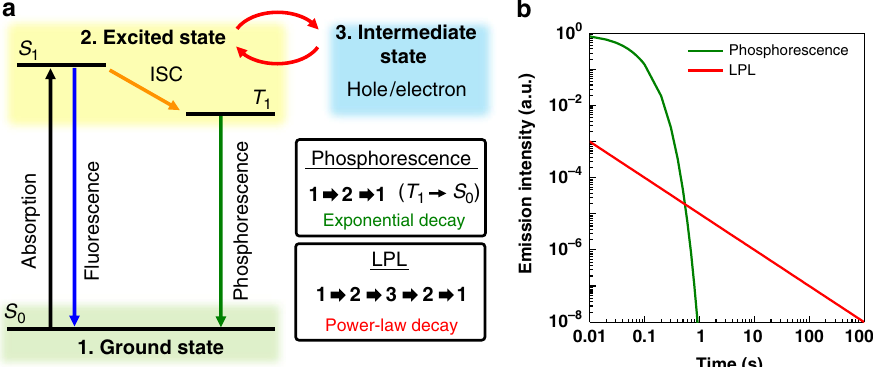
Fig. 1 Differences between LPL and phosphorescence. a Schematic diagram of fl uorescence, phosphorescence, and LPL. Phosphorescence is a transition from the triplet excited state (T 1 ) to the singlet ground state (S 0 ). LPL is an emission mechanism in which the energy passes through an intermediate state such as a trapped state. There is no restriction regarding the spin state. Although LPL is long-lived because of charge separation and subsequent slow recombination (second-order kinetics) of initially generated excitons, phosphorescence is long-lived because of the low probability of the transition ( fi rst- order kinetics) occurring in the initially generated excitons. b The ideal emission decay pro fi les of phosphorescence and LPL on logarithmic plots. Phosphorescence follows an exponential decay and LPL a power-law